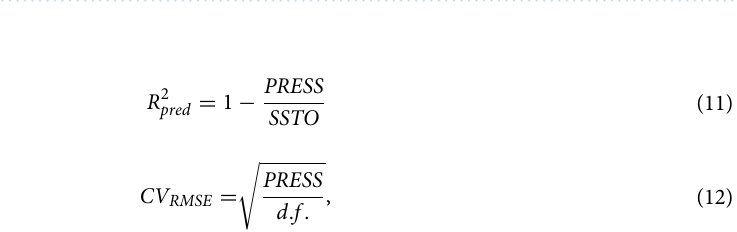
Table 6. The Tukey HSD Post-Hoc analysis: multiple comparisons among the 5 allometric models. Pantropical model 2 found to be not statistically significantly different from the Local model (Model 5).